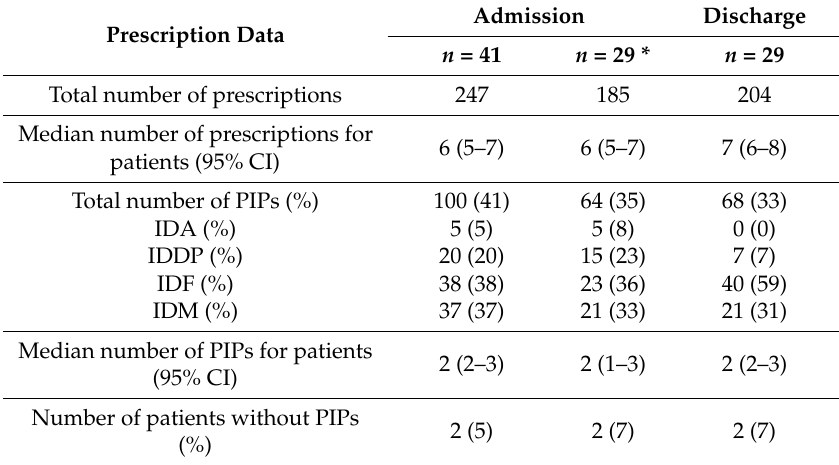
Figure 1. Distribution of ( A ) number of prescriptions per patient and ( B ) number of potentially inappropriate prescriptions (PIPs) per patient at admission and discharge. Table 2. Number and mean values of appropriate and PIPs at admission and discharge.